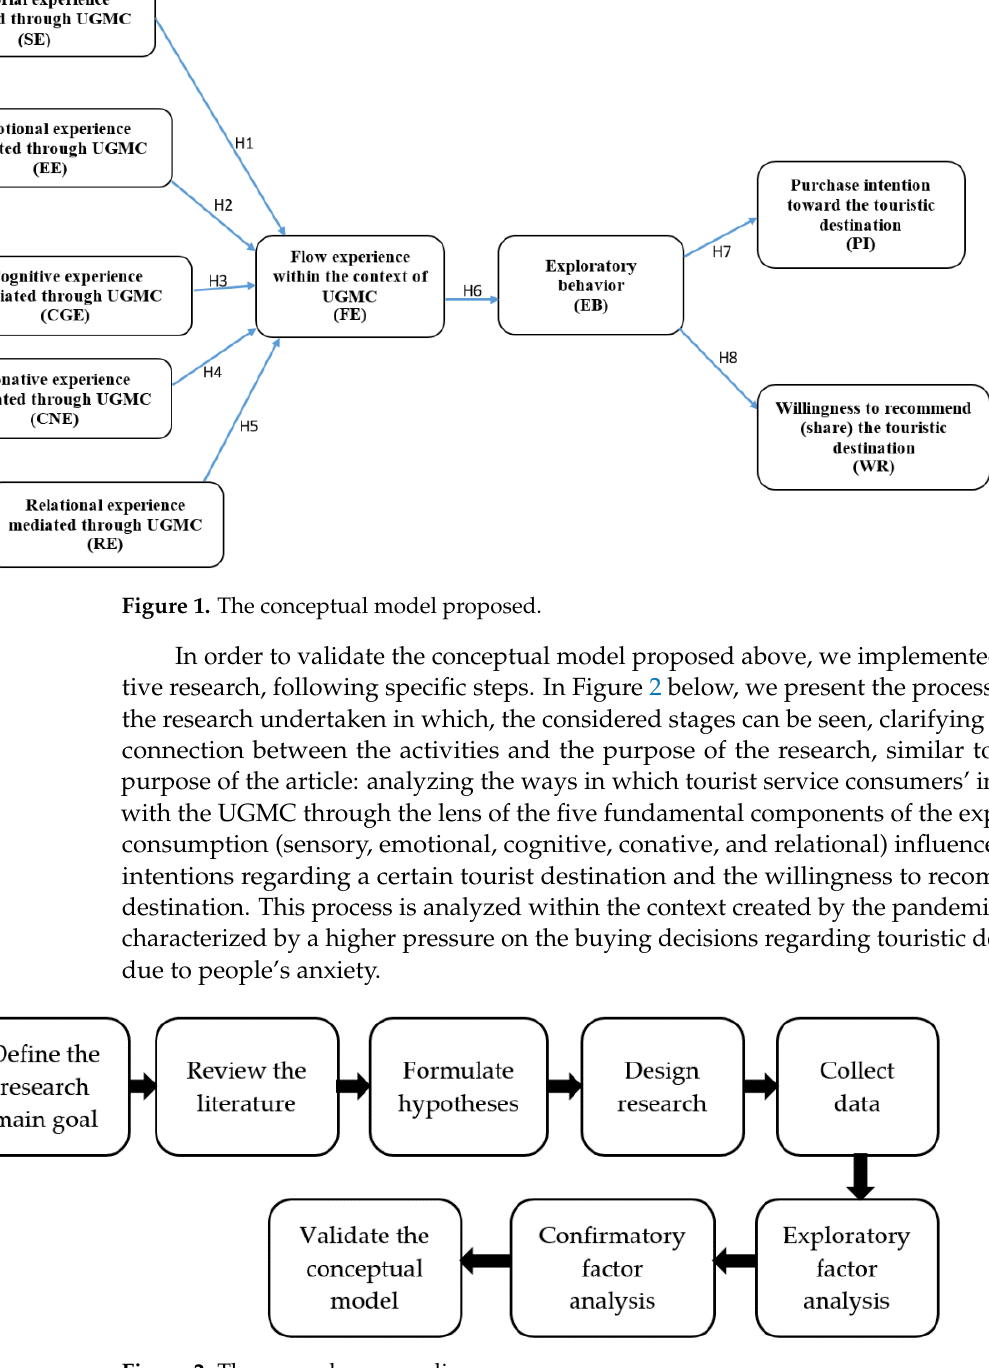
Figure 2. The research process diagram .